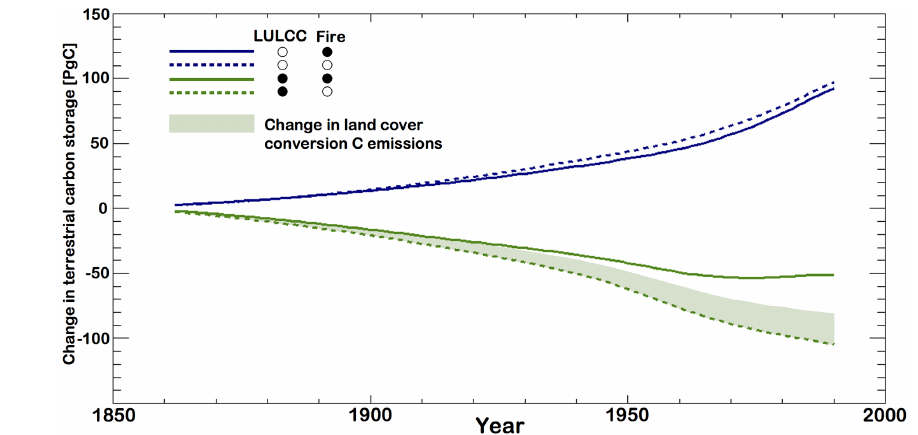
Figure 3. Time series of the historical change in global terrestrial carbon storage for Community Land Model (CLM) simulations with and without LULCC (green and blue, respectively), and with and without fires (solid and dashed, respectively), relative to the year 1850. Changes in carbon storage due to increased land cover conversion carbon emissions when fires are removed are shaded in light green. The time series is smoothed with a 25-year running